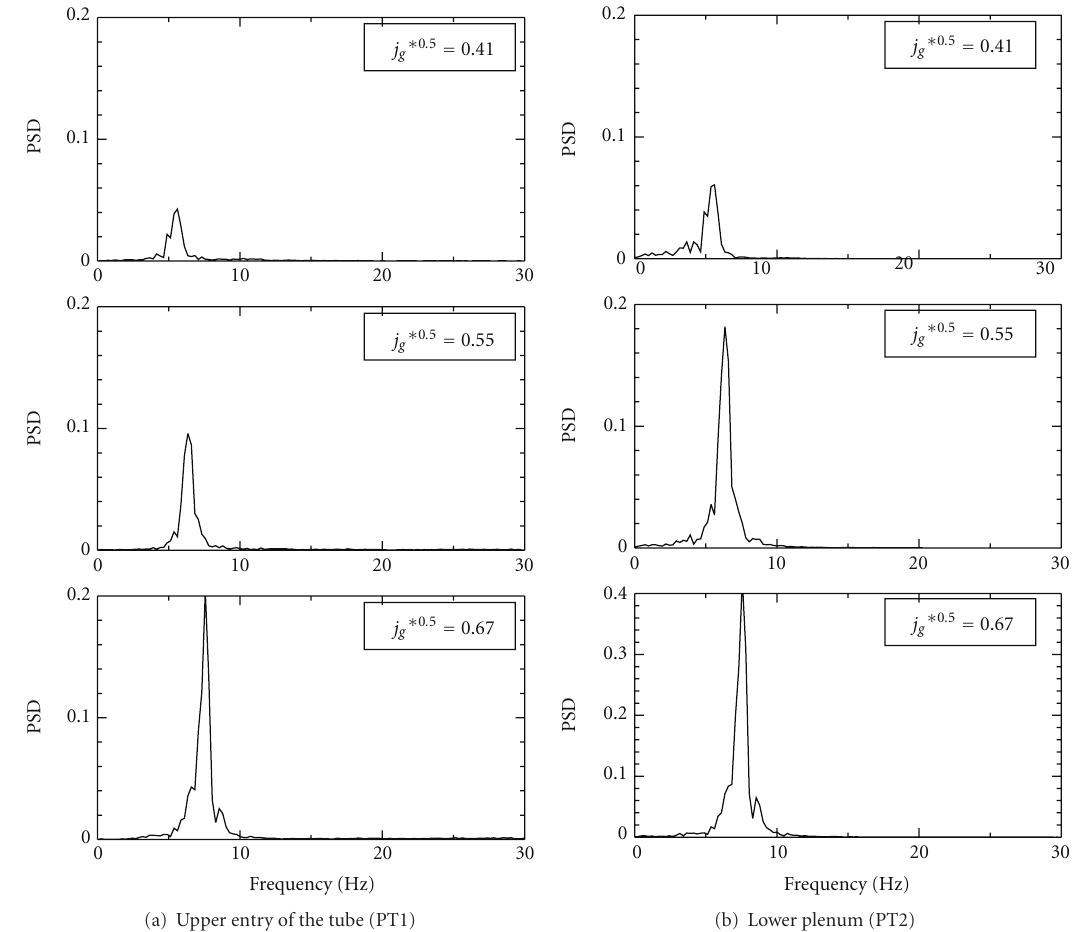
Figure 10: Power spectrum density (PSD) of pressure fluctuations for various air flow rate (tube diameter, D =